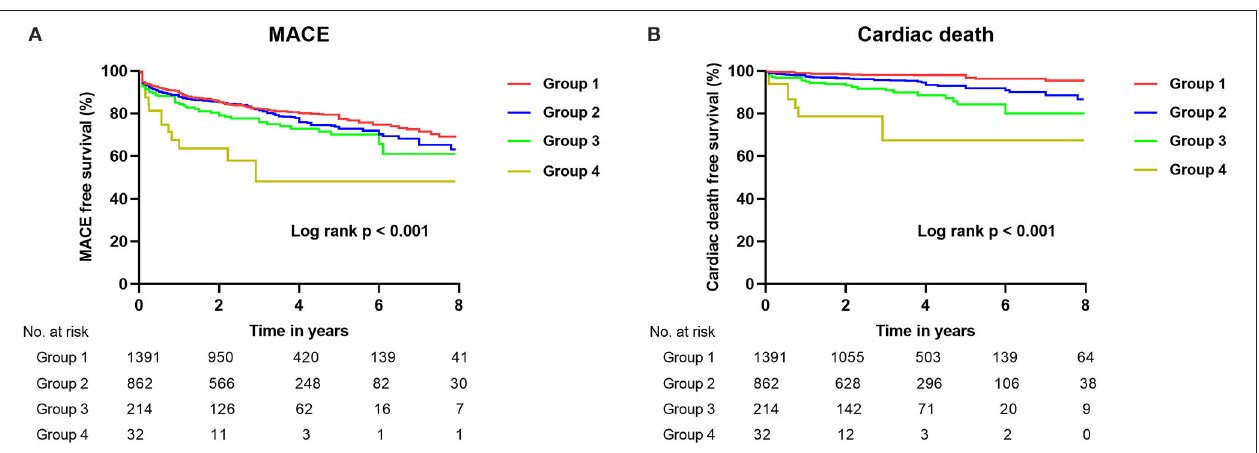
FIGURE 1 | Kaplan–Meier curves for MACE (A) and cardiac death (B) during follow-up in total patients with CTO according to baseline renal function. CTO, chronic total occlusion; MACE, major adverse cardiovascular events; Group 1 [estimated glomerular filtration rate (eGFR) ≥ 90 ml/min/1.73 m 2 ]; Group 2 (60 ≤ eGFR < 90